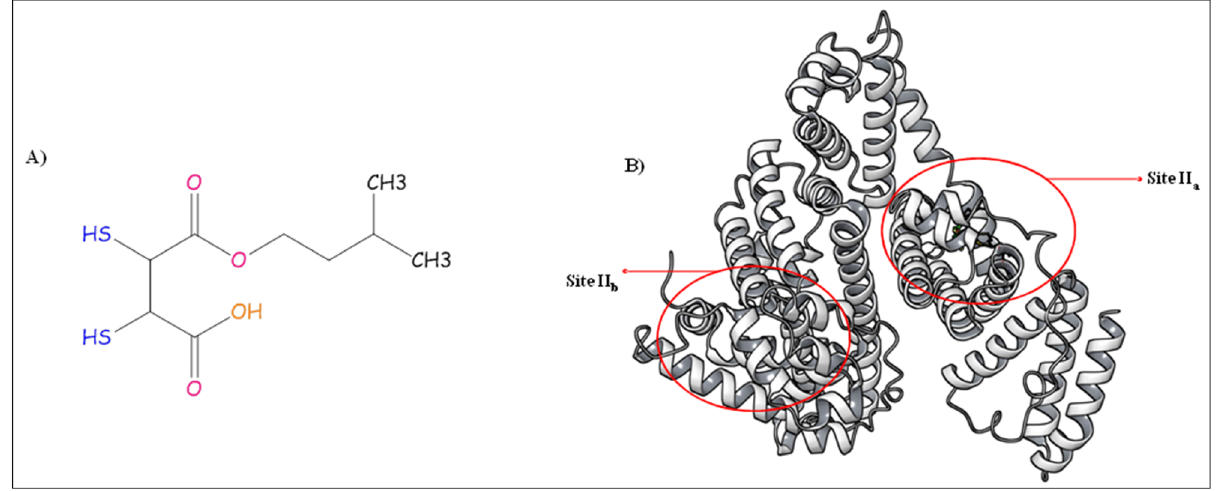
Figure 1. ( A ) Chemical structure of MiADMSA (Chem BioDraw Ultra, 14.0) ( B ) Crystal structure of BSA (PDB ID: 4F5S) with two possible binding sites (Desmond Academic license 2018-4, https ://www.schro dinge r.com/citat ions#Desmo